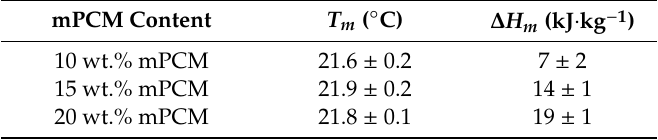
Table 6. Di ff erential scanning calorimetry (DSC) results for the formulations under Table 6. Differential scanning calorimetry (DSC) results for the formulations under study.